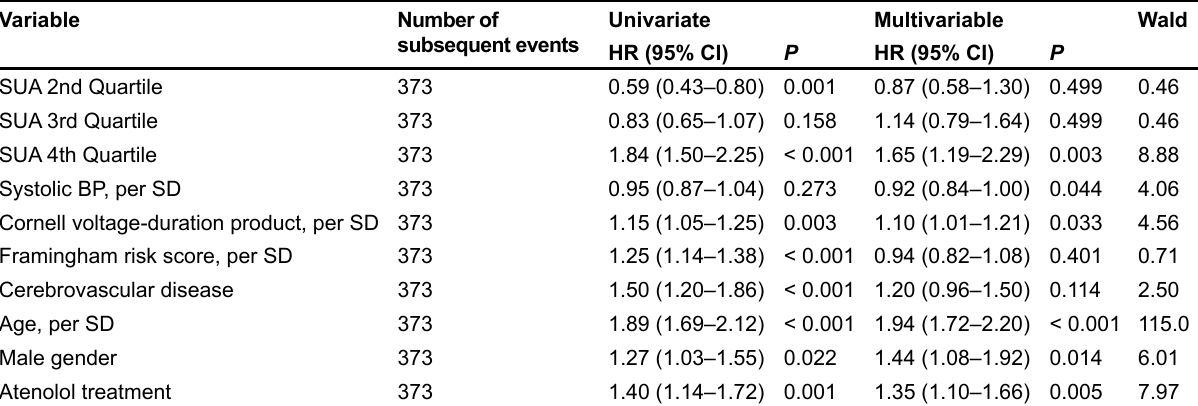
Table 3. Univariate and multivariable Cox models for prediction of new-onset AF by sex-specific SUA quartiles and systolic BP as time-varying